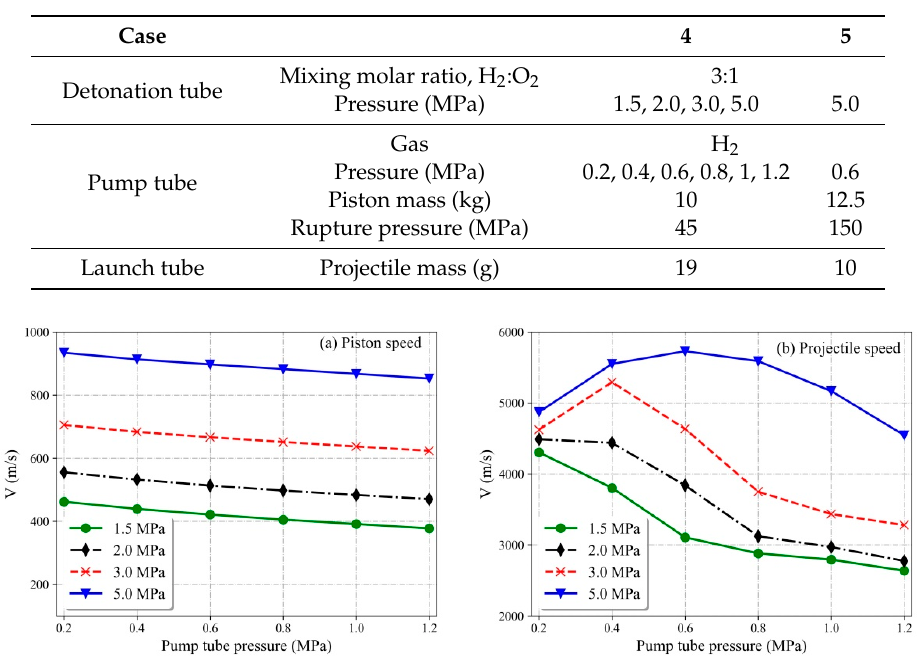
Table 2. Operating conditions in the simulation of Case 4 and Case 5.